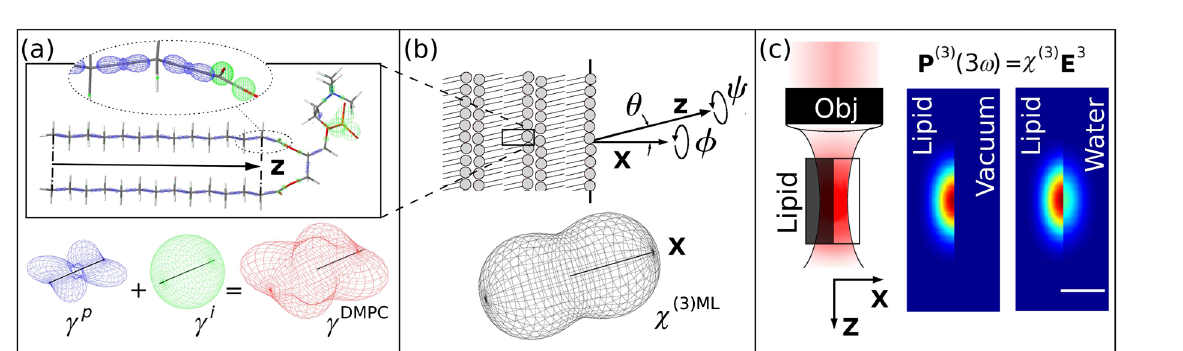
FIG. 1. Visual summary of calculations. (a) In the bond-additivity model, each bond contributes (cid:1) mol . The non-CC bonds contribute isotropically while the CC-bond directions give rise to a directed (cid:3) ð 3 Þ . The nonlinear dipole moment j e r ð 3 Þ ð 3 ! Þj is calculated as a function of excitation angle [Eq. (1)] for (cid:1) p (blue mesh), (cid:1) i (green mesh), and (cid:1) DMPC (red mesh). The black lines are the same length and indicate the molecular z axis. (b) The lipids within the bilayer rotate freely about c , (cid:4) and adopt a Gaussian distribution of angles relative to the bilayer normal (laboratory X axis). Averaging of (cid:1) DMPC about these axes results in (cid:3) ð 3 Þ ML . The grey mesh shows the lipid nonlinear polarization j P ð 3 Þ ð 3 ! Þj , and the black line indicates the bilayer normal. (c) Left: Simulated focal volume half-filled with ordered lipid (dark gray) and either vacuum or water (clear). Right: Focal distribution of induced P ð 3 ! Þ in each material at the focus ¼ n ¼ 1 : 33 , scale bar 500 ( NA ¼ 0 : 8 , (cid:5) ¼ 1180 nm , n ! 3 !